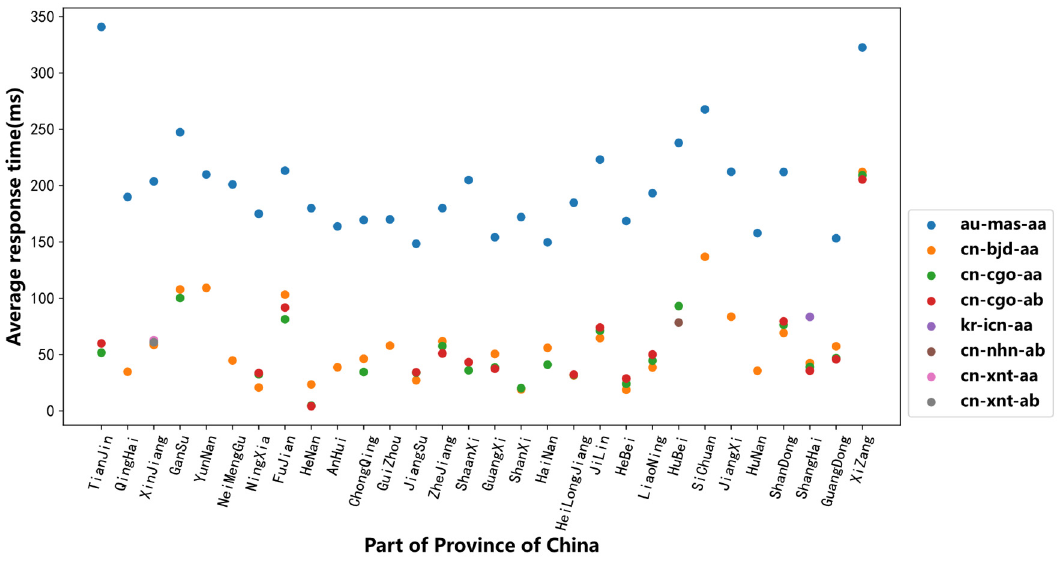
Figure 12. Average response times of three type nodes of L root in different provinces.